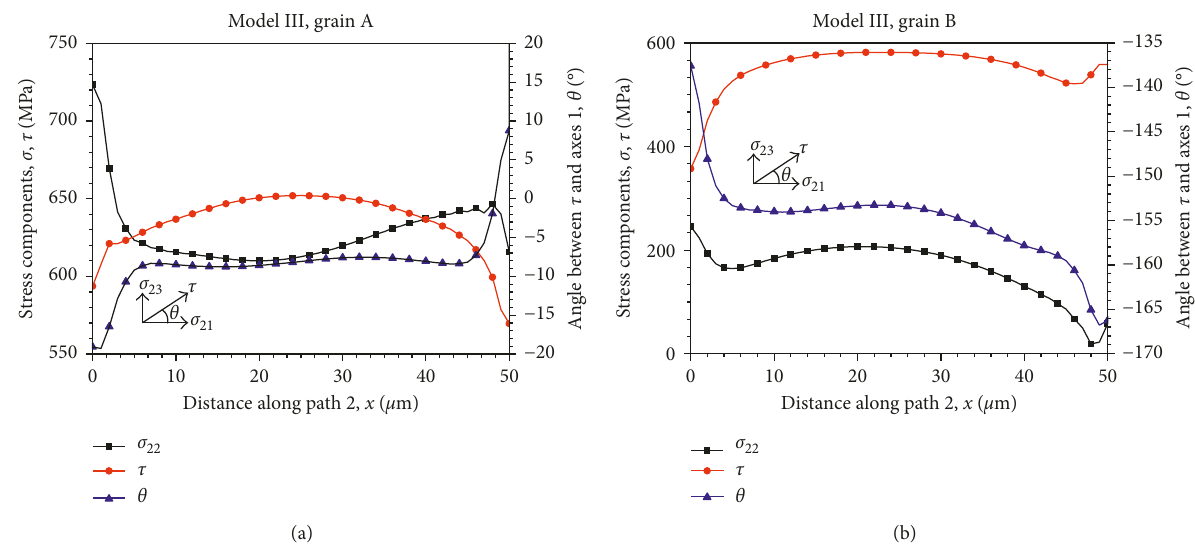
Figure 16: Stress components on model III GB: (a) grain A and (b) grain B.